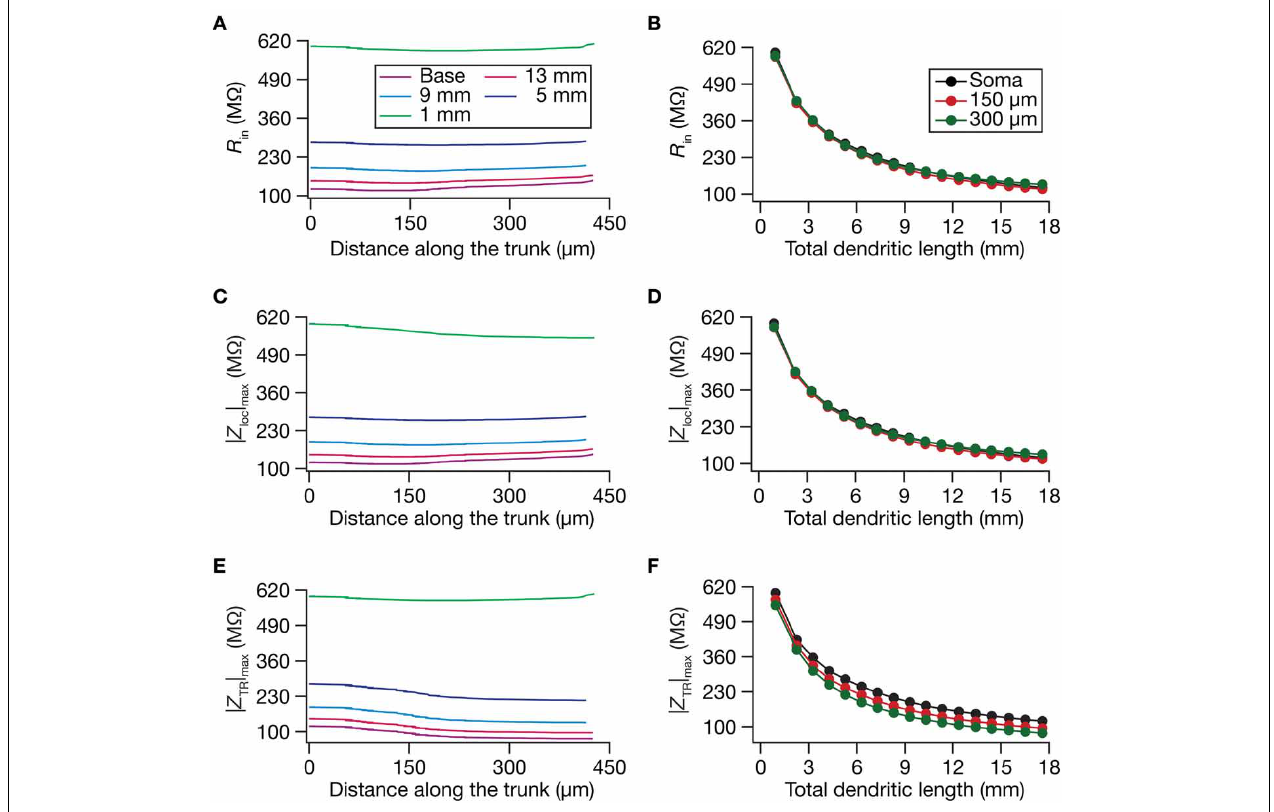
FIGURE 2 | Steady-state and frequency-dependent measures of excitability increased with dendritic atrophy across somatodendritic locations of a passive neuronal model. (A,B) Input resistance ( R in ) plotted as functions of somatodendritic location ( A ; for 5 different pruned morphologies, Figure 1A ) and total dendritic length ( B ; for 3 distinct somatodendritic locations,